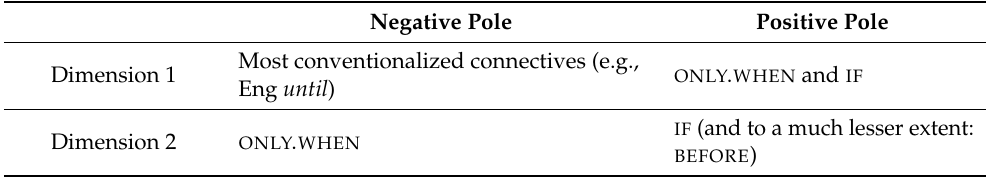
Table 6. Poles of dimensions 1 and 2 from the principal components.